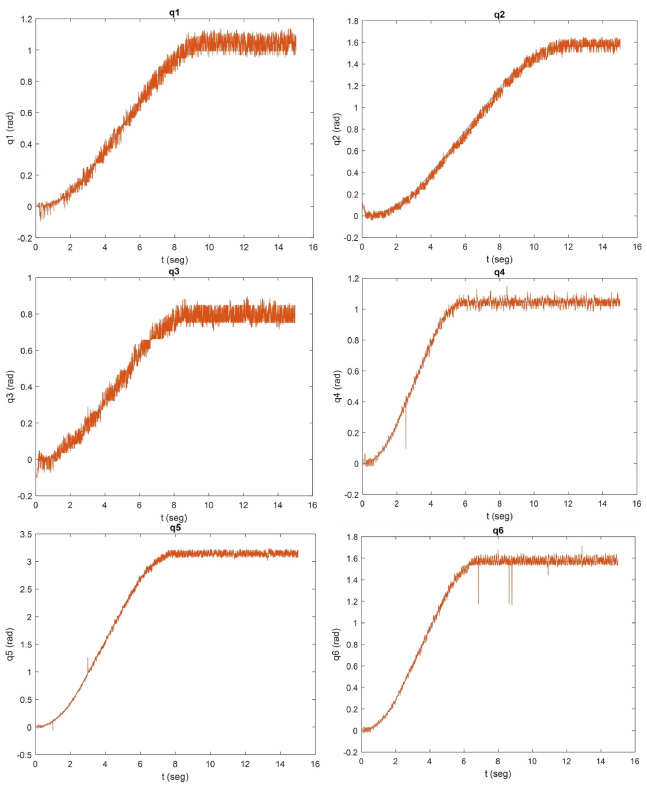
Figure 15. Tracking of the physical